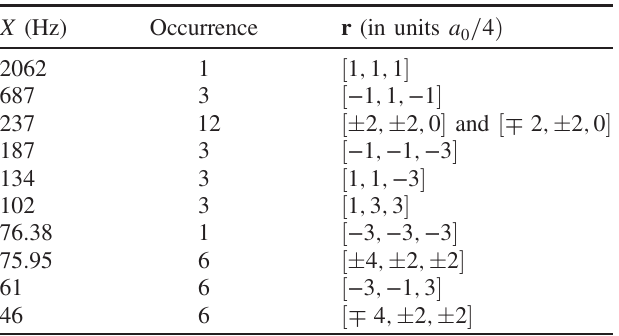
TABLE I. The occurrence of a given coupling X when